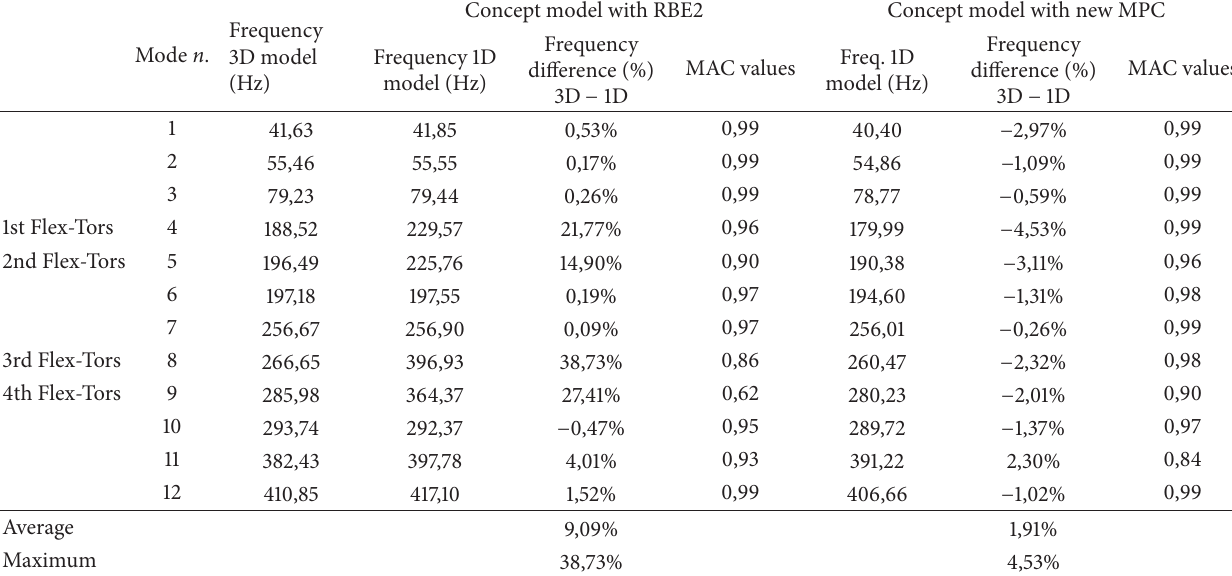
Table 3: Dynamic comparison between the original and the two-concept FE models, in terms of natural frequencies, % errors, and modal correlation